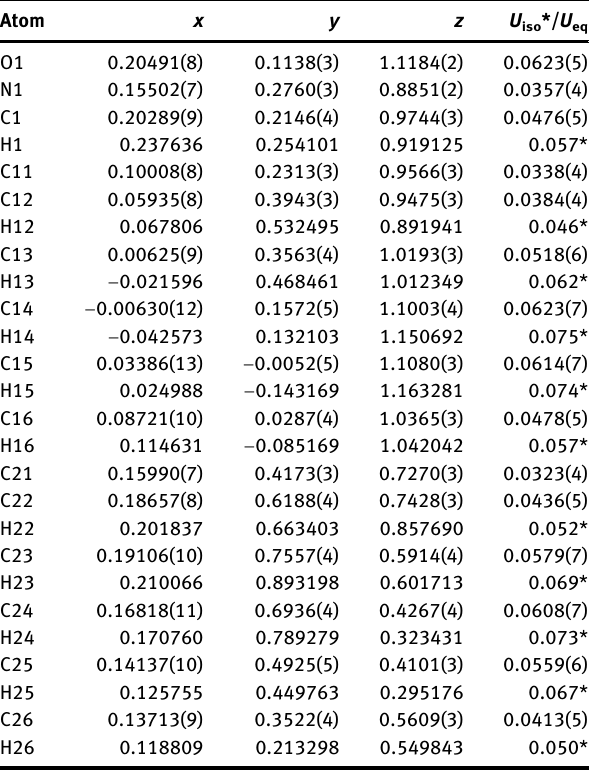
Table  : Fractional atomic coordinates and isotropic or equivalent isotropic displacement parameters (Å 